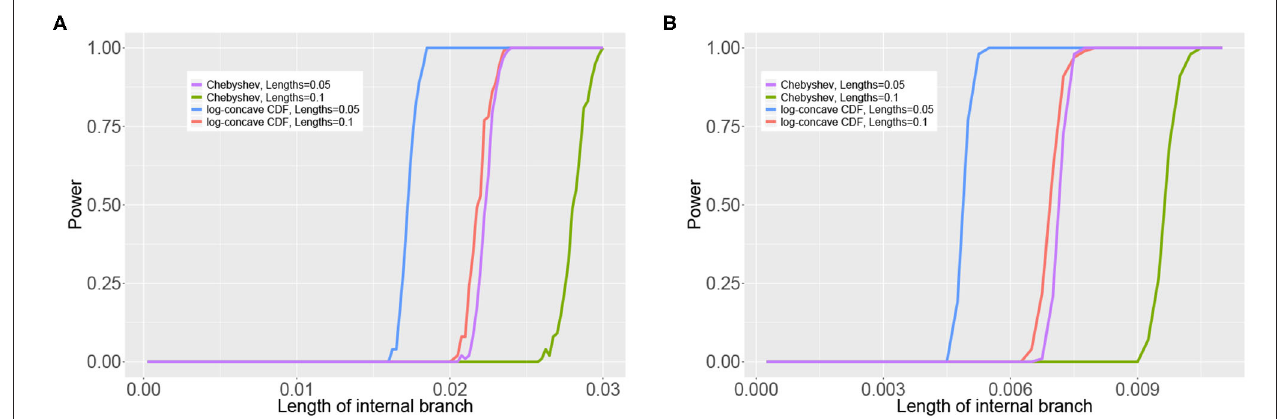
FIGURE 6 | Results of the simulation study that varied the length of the internal branch in the tree in Figure 3C . The y -axis shows the power of the tests based on the Chebyshev bound and on the log-concave CDF bound for varying lengths of the internal branch ( x -axis) using ( S T 2 4 ( 500,000 bp (B) . The remaining branch lengths were set to either 0.05 or 0.1.